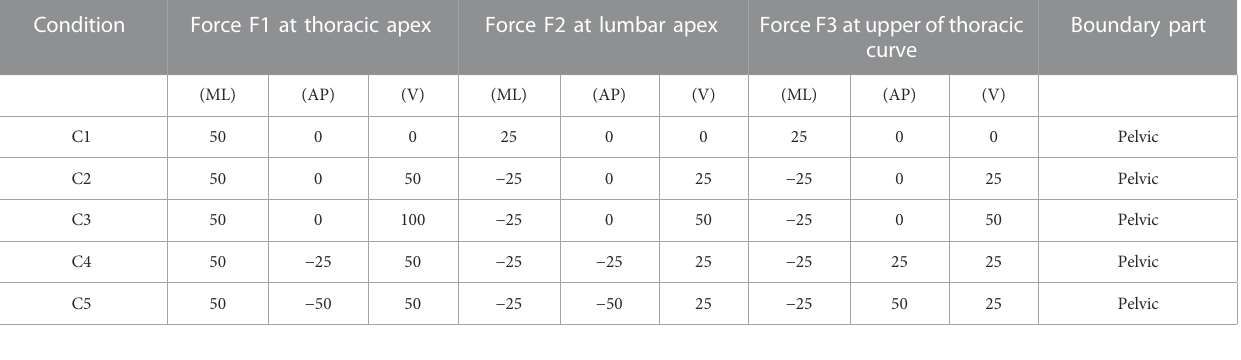
TABLE 3 Various force con fi gurations and magnitudes. Condition Force F1 at thoracic apex Force F2 at lumbar apex Force F3 at upper of thoracic